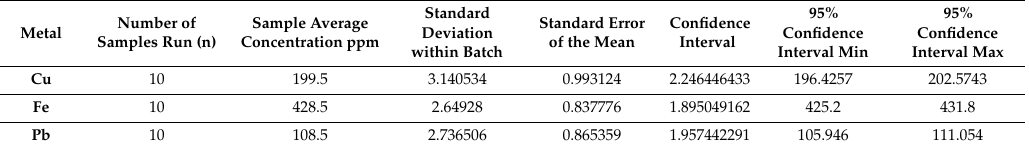
Table 3. Concentration of metals in the soil of the Jam-Chakro landfill